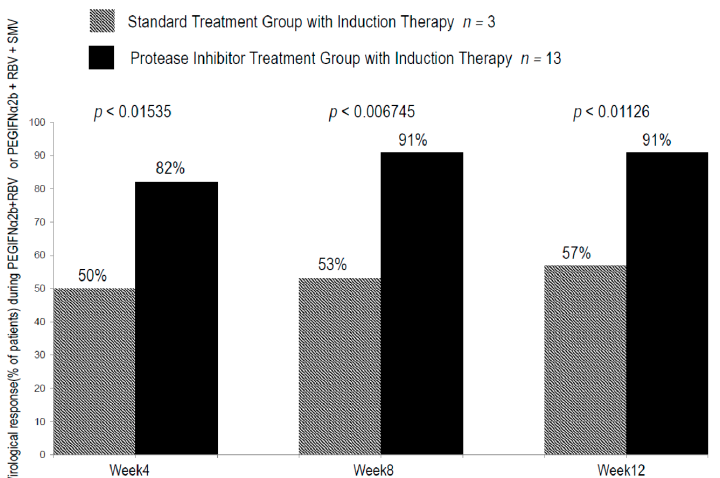
Figure 4. Rate of early virologic responses in the initial 4, 8 and 12 weeks in chronic hepatitis C patients with genotype 1b and high viral loads during standard treatment with induction therapy with nIFN- β and protease inhibitor treatment with induction therapy with nIFN- β . Virologic response was defined as undetectable serum level HCV.RNA (<15 IU/mL). The paired-t test was used to evaluate the differences of the means between two groups with a p -value of <0.05 considered significant.